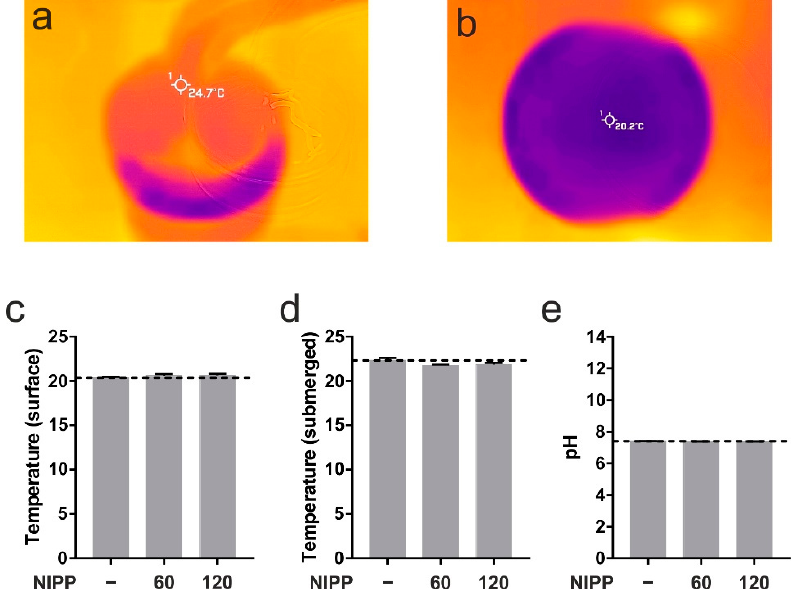
Figure 4. Basic characterisation of NIPP. ( a ) Superficial temperature of NIPP probe PS30 at DBD mode; ( b , c ) superficial temperature of cell culture medium prior to NIPP treatment (-) up to 120 s of treatment, respectively; ( d ) submerged temperature of cell culture medium during 120 s of NIPP treatment; ( e ) pH of cell culture medium during 120 s of NIPP treatment.